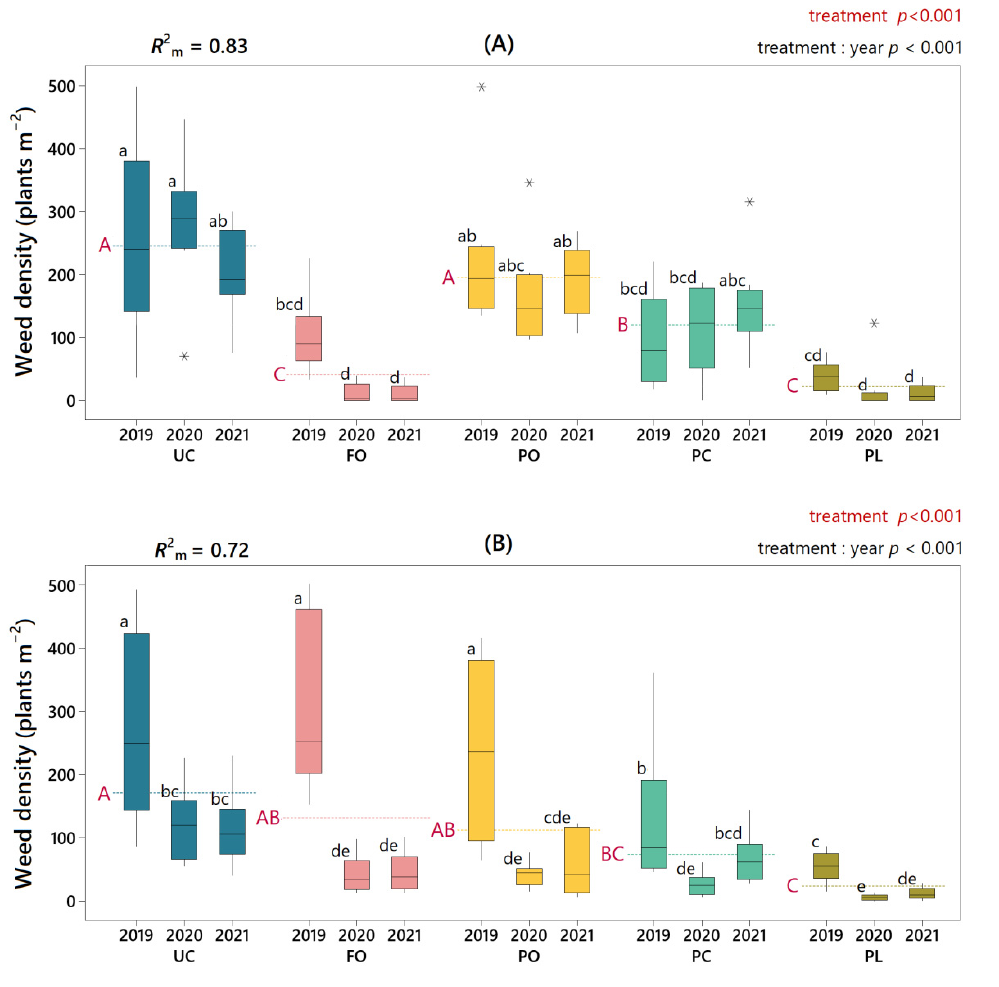
Figure 2. Weed density (plants m − 2 ) according to treatment and year on farm A ( A ) and farm B ( B ). Dashed lines mark the three-year mean for each treatment (UC, untreated control; FO, Festuca ovina living mulch; PO, Pilosella officinarum living mulch; PC, Plantago coronopus living mulch; PL, Plantago lanceolata living mulch). Significance levels ( p -values) of the factor “treatment” and of the interaction between “treatment” and “year” are indicated text in red and black ink, respectively. For “treatment” level, means were significantly different if red capital letters next to the dashed lines are different. For “treatment: year” level, boxes with different lower-case black letters had significantly different means. In the upper left corner, R 2m indicates the variance explained by the fixed effects of the mixed model. Outliers are indicated with an asterisk (*). Table 4. Effect of treatments on the density of weeds with a significant occurrence (relative density > 3%). Those species classified as noxious weeds are indicated with an asterisk next to the EPPO code. The percentage of variation in weed density that is explained by the fixed effects of the model is indicated ( R 2m ). A type III ANOVA was used to calculate the significance level of the effect ( p -values: *** p < 0.001, ** p < 0.01, * p < 0.05, ns not significant), followed by a t -test adjusted with a Bonferroni correction for pairwise comparison. For each farm, treatment means sharing the same letter within each row are not significantly different.